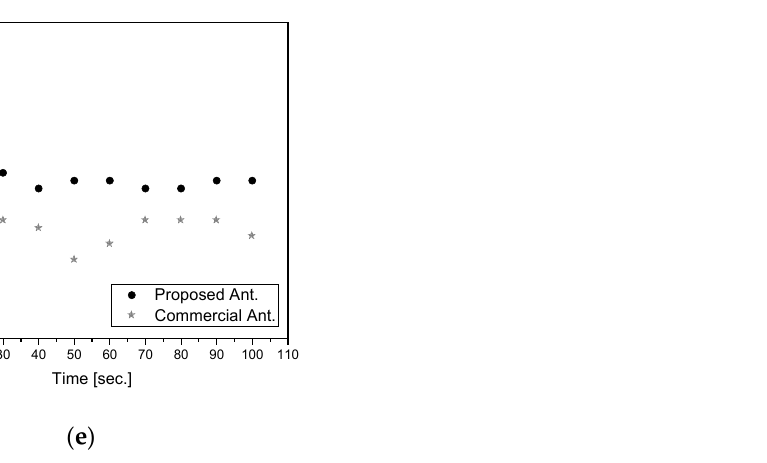
Figure 8. RSSI tests on the earphones without and with the head phantom ( a ) RF-to-RF link test as in Section 3 ( b ) Concept of the RSSI test without the SAM and RSSI ( c ) RSSI of direct link tests ( d ) Concept of the RSSI in the cross-head link and RSSI test ( e ) RSSI of cross-head link tests.